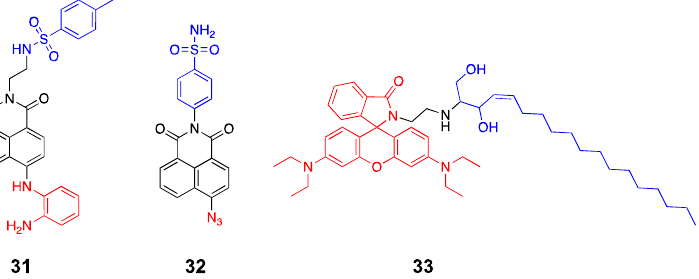
Figure 8. Endoplasmic reticulum (ER)- and Golgi-targeted probes (blue: targeting moiety; red: responsive moiety).